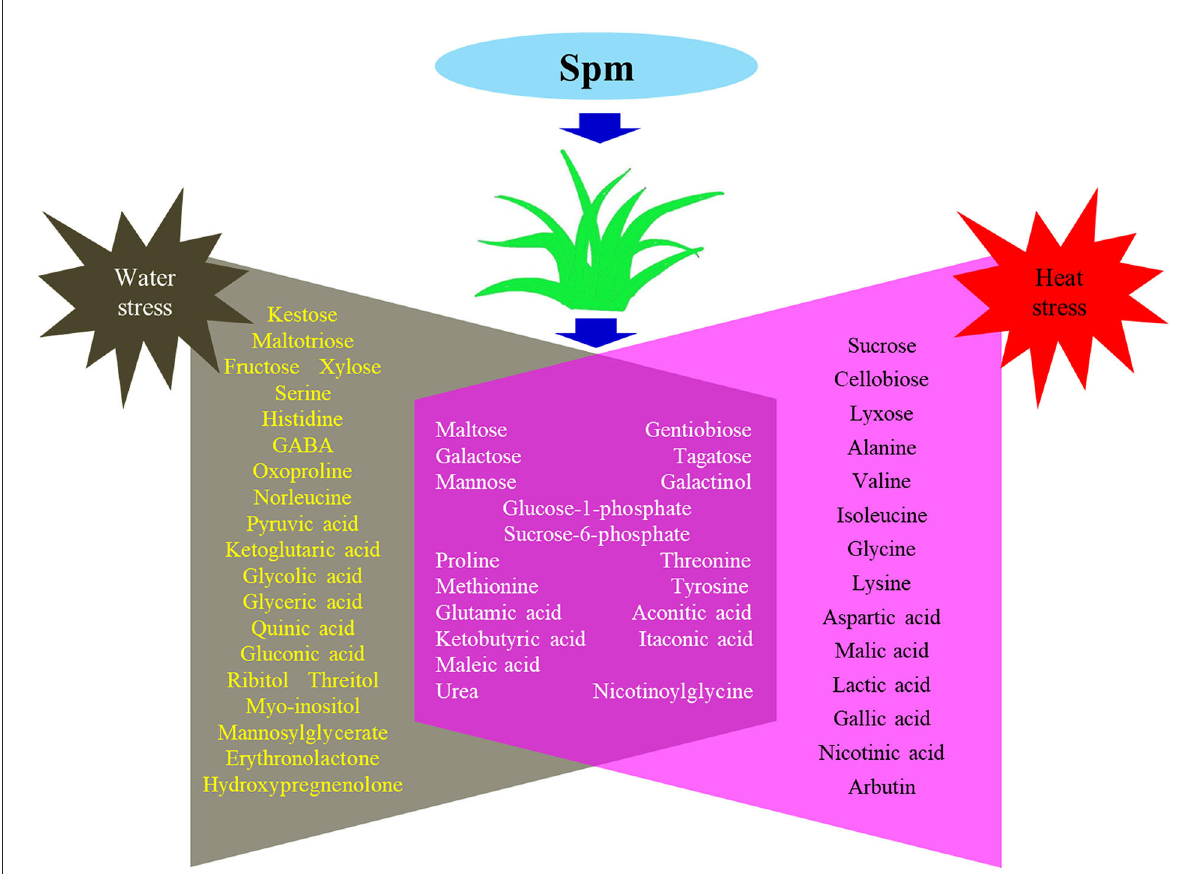
FIGURE7 Common and differential metabolites regulated by spermine under water stress and heat stress in leaves of creeping